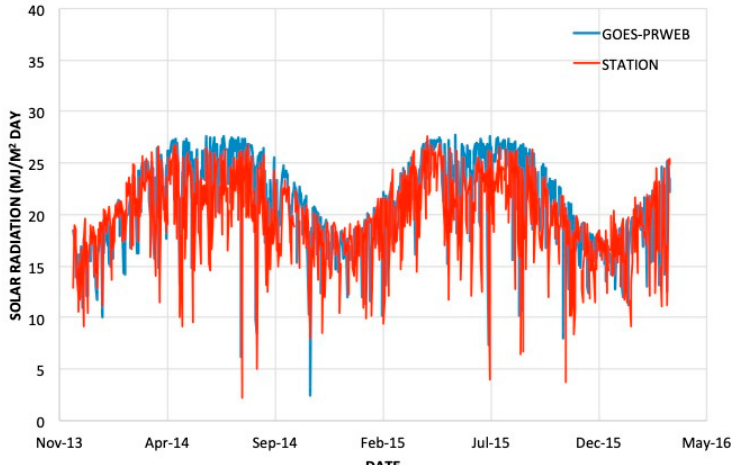
Figure A5. Modeled and observed R s from January 2014 to April 2016 at the UPR Agricultural Experimental Station near Juan Diaz, Puerto Rico.